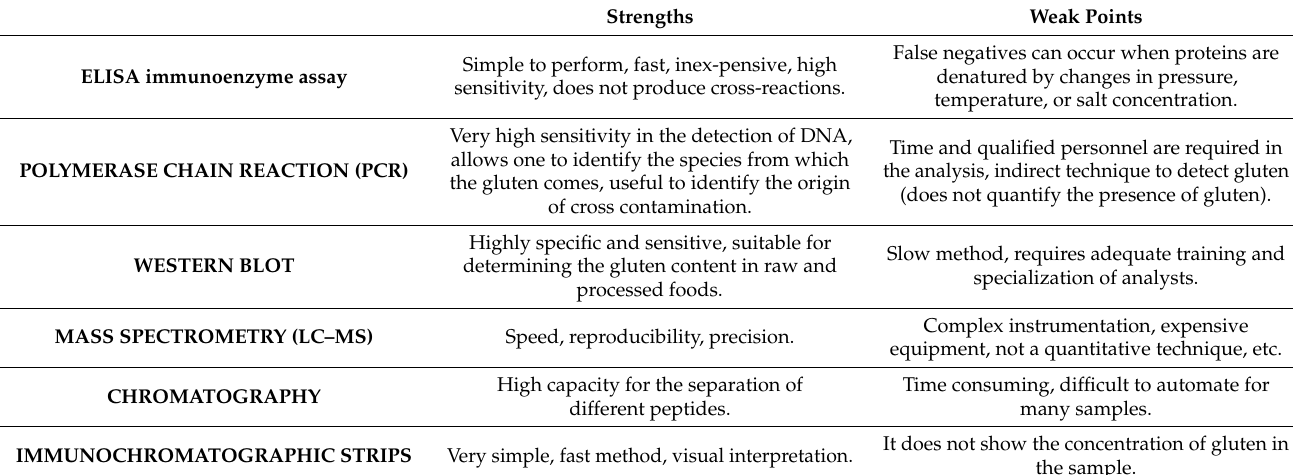
Table 2. Analytical techniques for the detection and quantification of gluten.